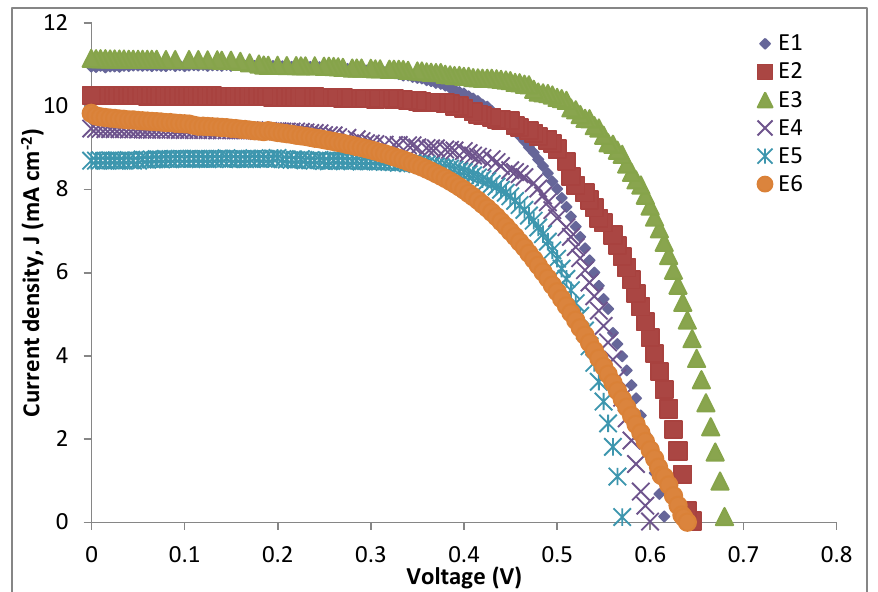
Fig. 3: The current density–photovoltage (J–V) of solar cells of arrangement Glass/FTO/TiO 2